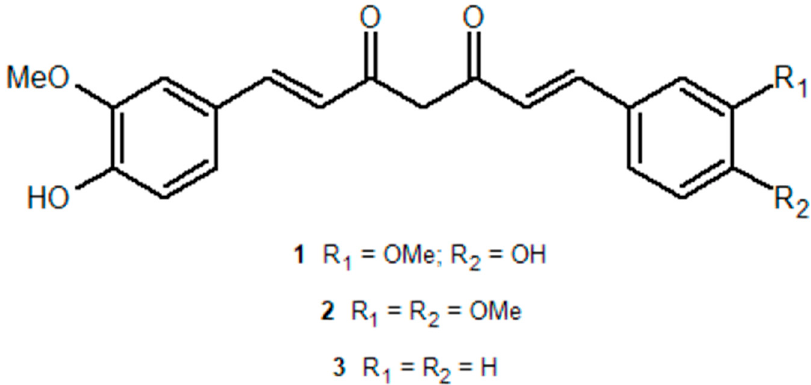
Figure 1. Chemical structures of the investigated curcuminoids.